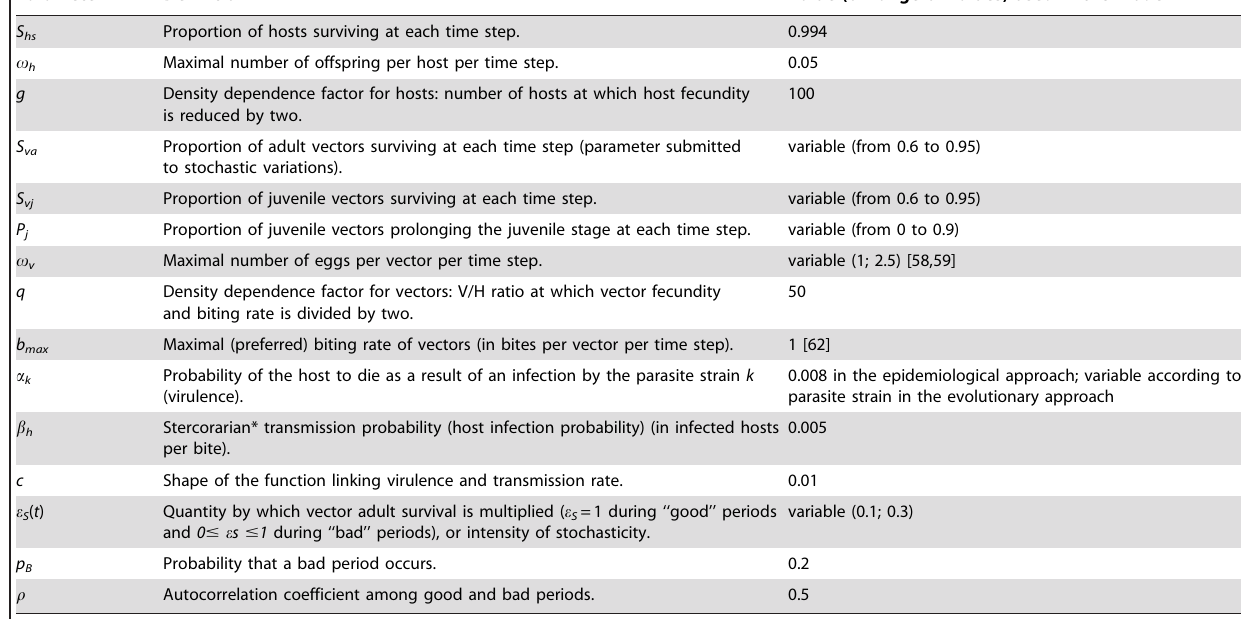
Table 1. Definition and values of the parameters used in the model.